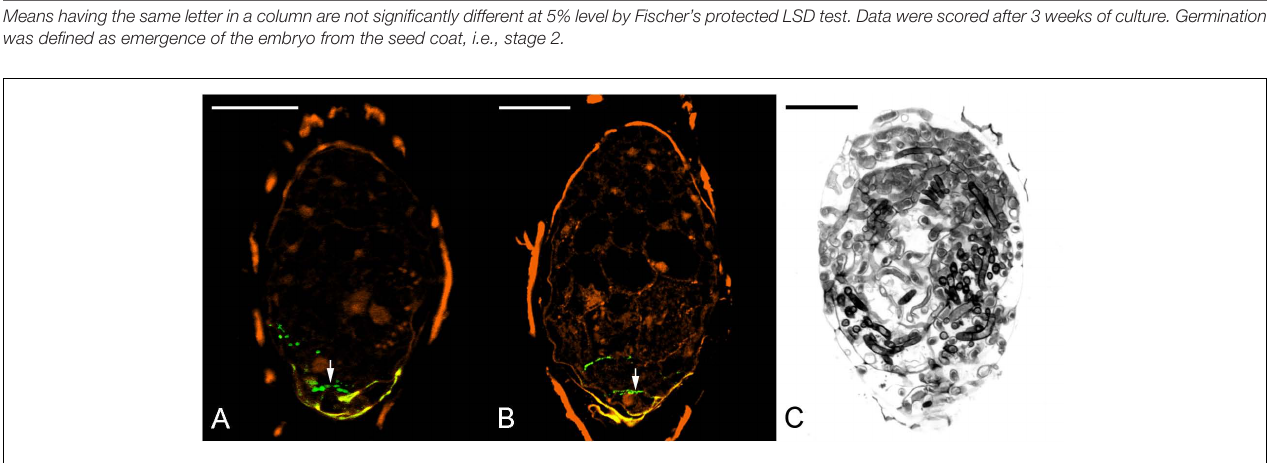
Frontiers in Plant Science |